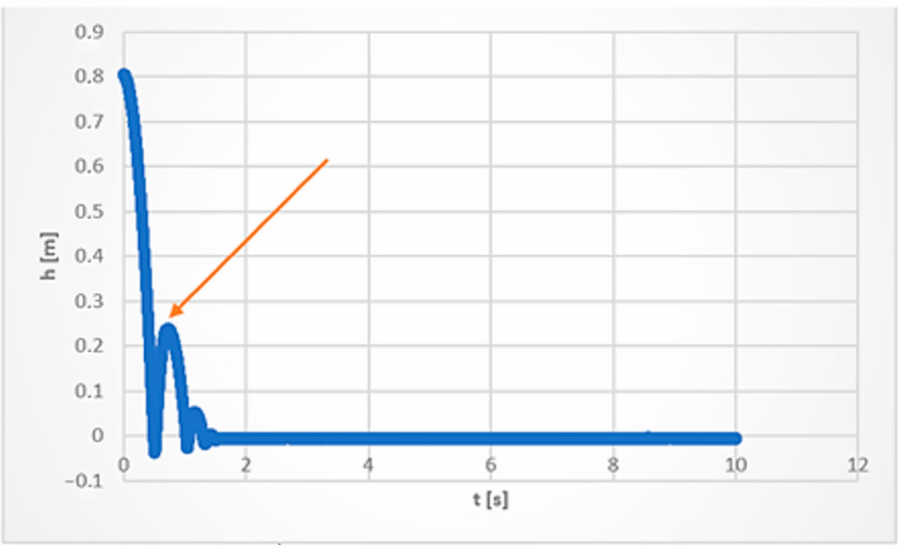
Figure 5. Bounce height h z of the hammer with the spherical impactor at an impact height of 0.8